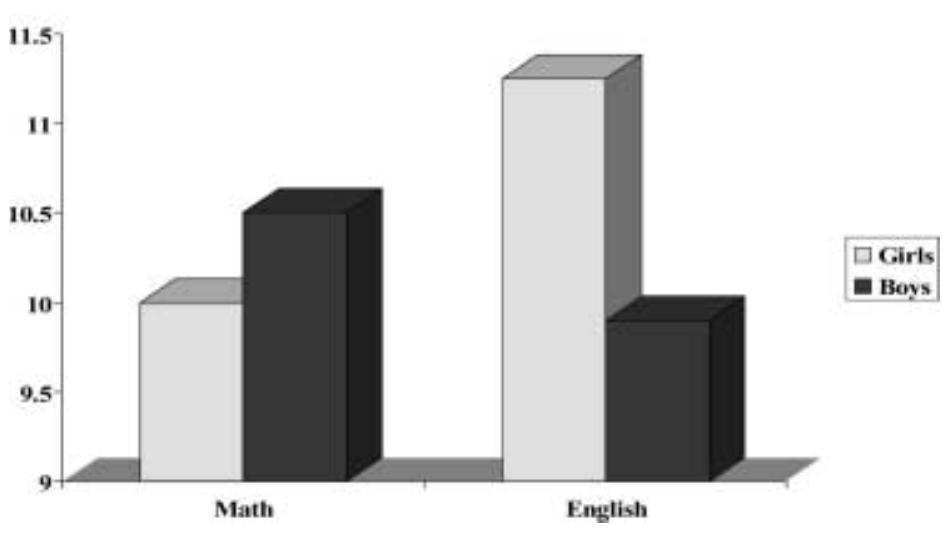
Figure 3. Parents’ expectations for adolescent child’s future